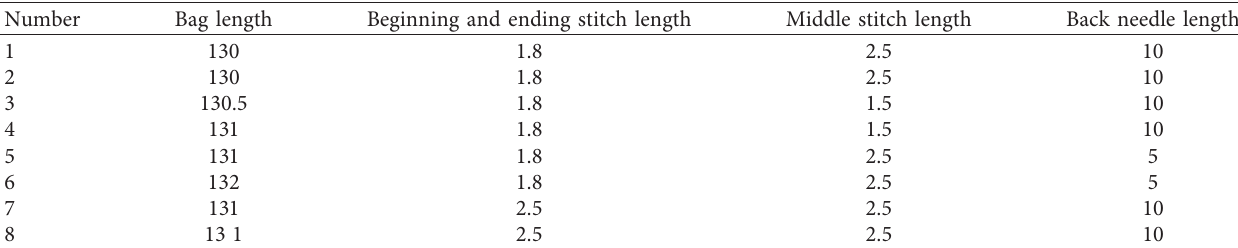
Table 6: 04 fabric research